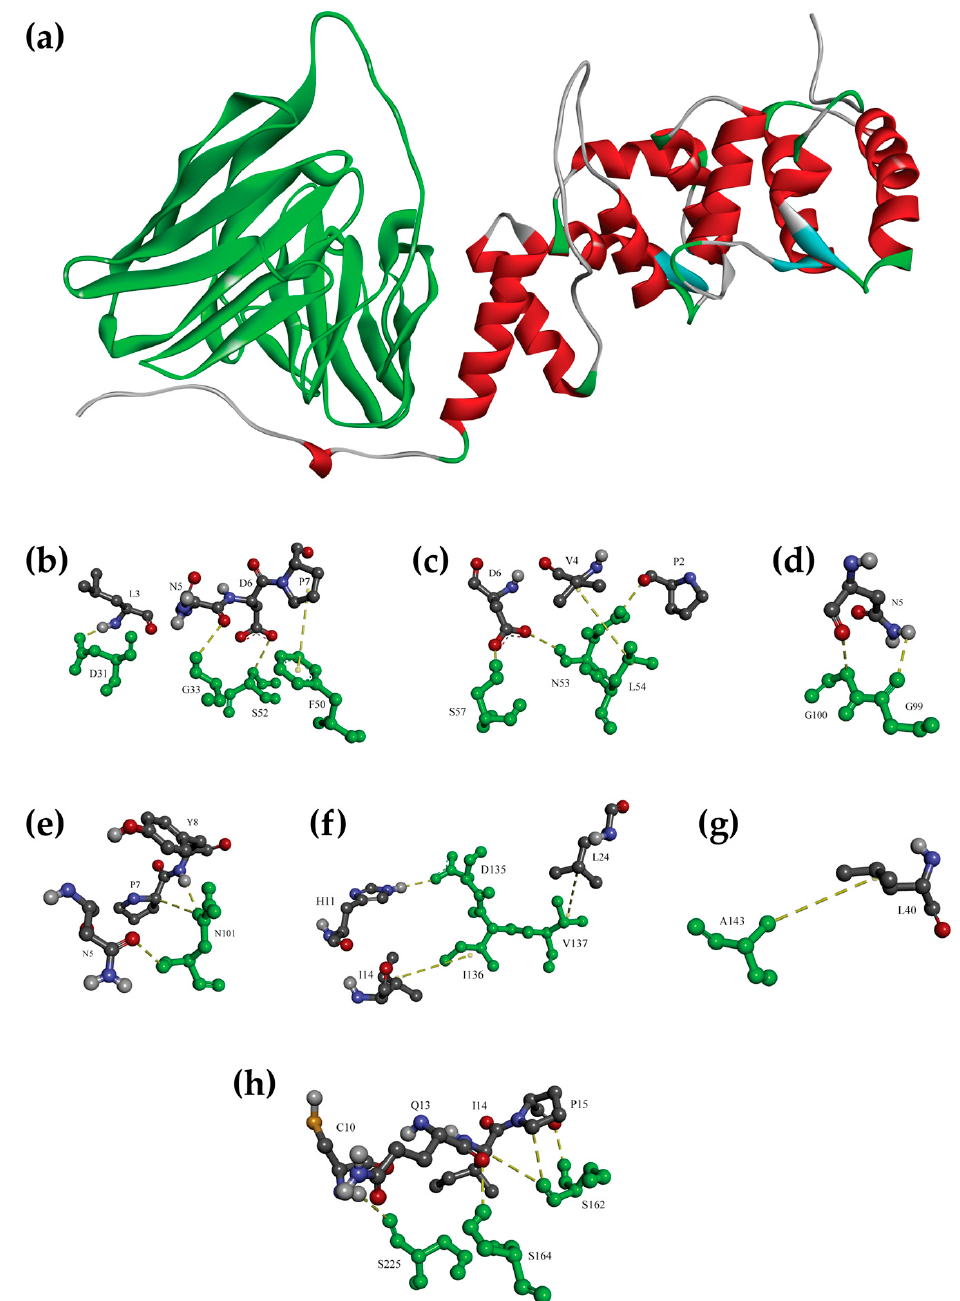
Figure 4. Computerized interactions between the modeled OvROPN1L ( red, mainly alpha - helical ) and scFv anti - OvROPN1L - CL19 ( green, mainly beta - sheets), as determined by molecular modeling and docking ( a ). The interacting amino acids of the antigen - binding domains of scFv anti - OvROPN1L - CL19 ( green sticks ) and the OvROPN1L peptide ( grey sticks ) are shown below ( b – h ). Interaction details are listed in Table 1. Amino acid interactions between the OvROPN1L peptide and scFv anti - OvROPN1L - CL19.